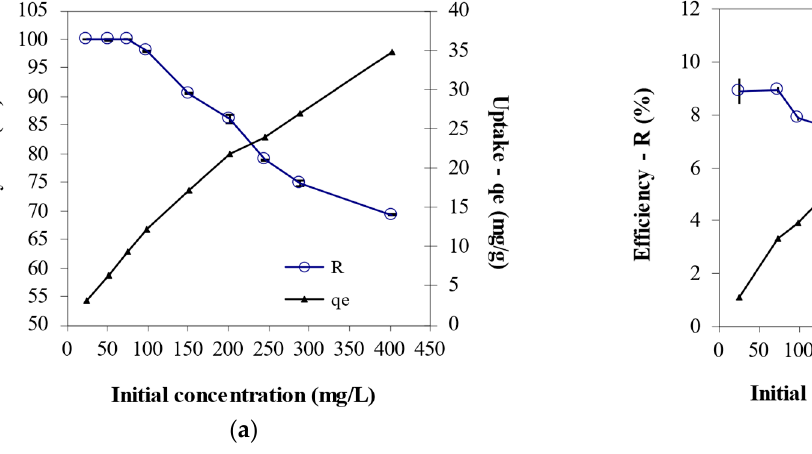
Figure 4. Effect of initial metal concentration on biosorption efficiency and metal uptake capacity of ( a ) Cr 6+ and ( b ) total chromium by B. megaterium inactive biomass (pH = 1, contact time = 48 ore, biosorbent dosage = 8 g/L, temperature = 25 °C).